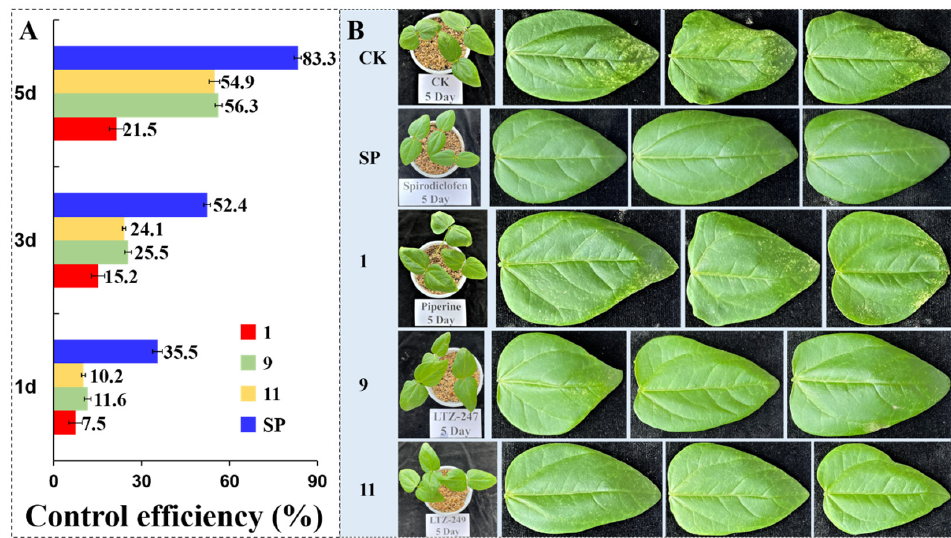
Figure 4. The control efficiency ( A ) and symptoms ( B ) of cowpea leaves infected with T. cinnabarinus on the 5th day after treatment with SP (spirodiclofen), 1 (piperine), 9 (LTZ–247), and 11 (LTZ–249) (CK: aq. Tween–80 (1 g/L)).